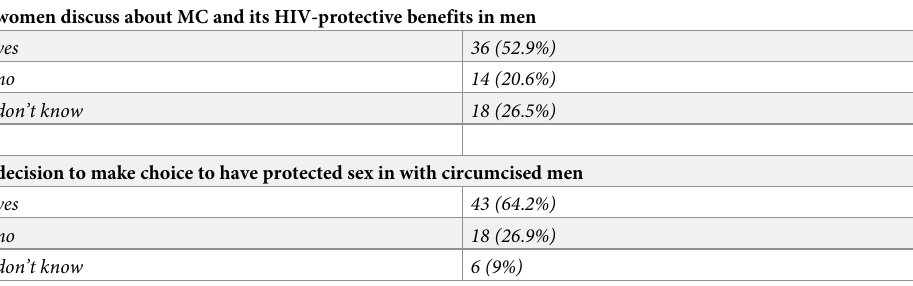
Table 4. Summary descriptive analysis of women involvement on